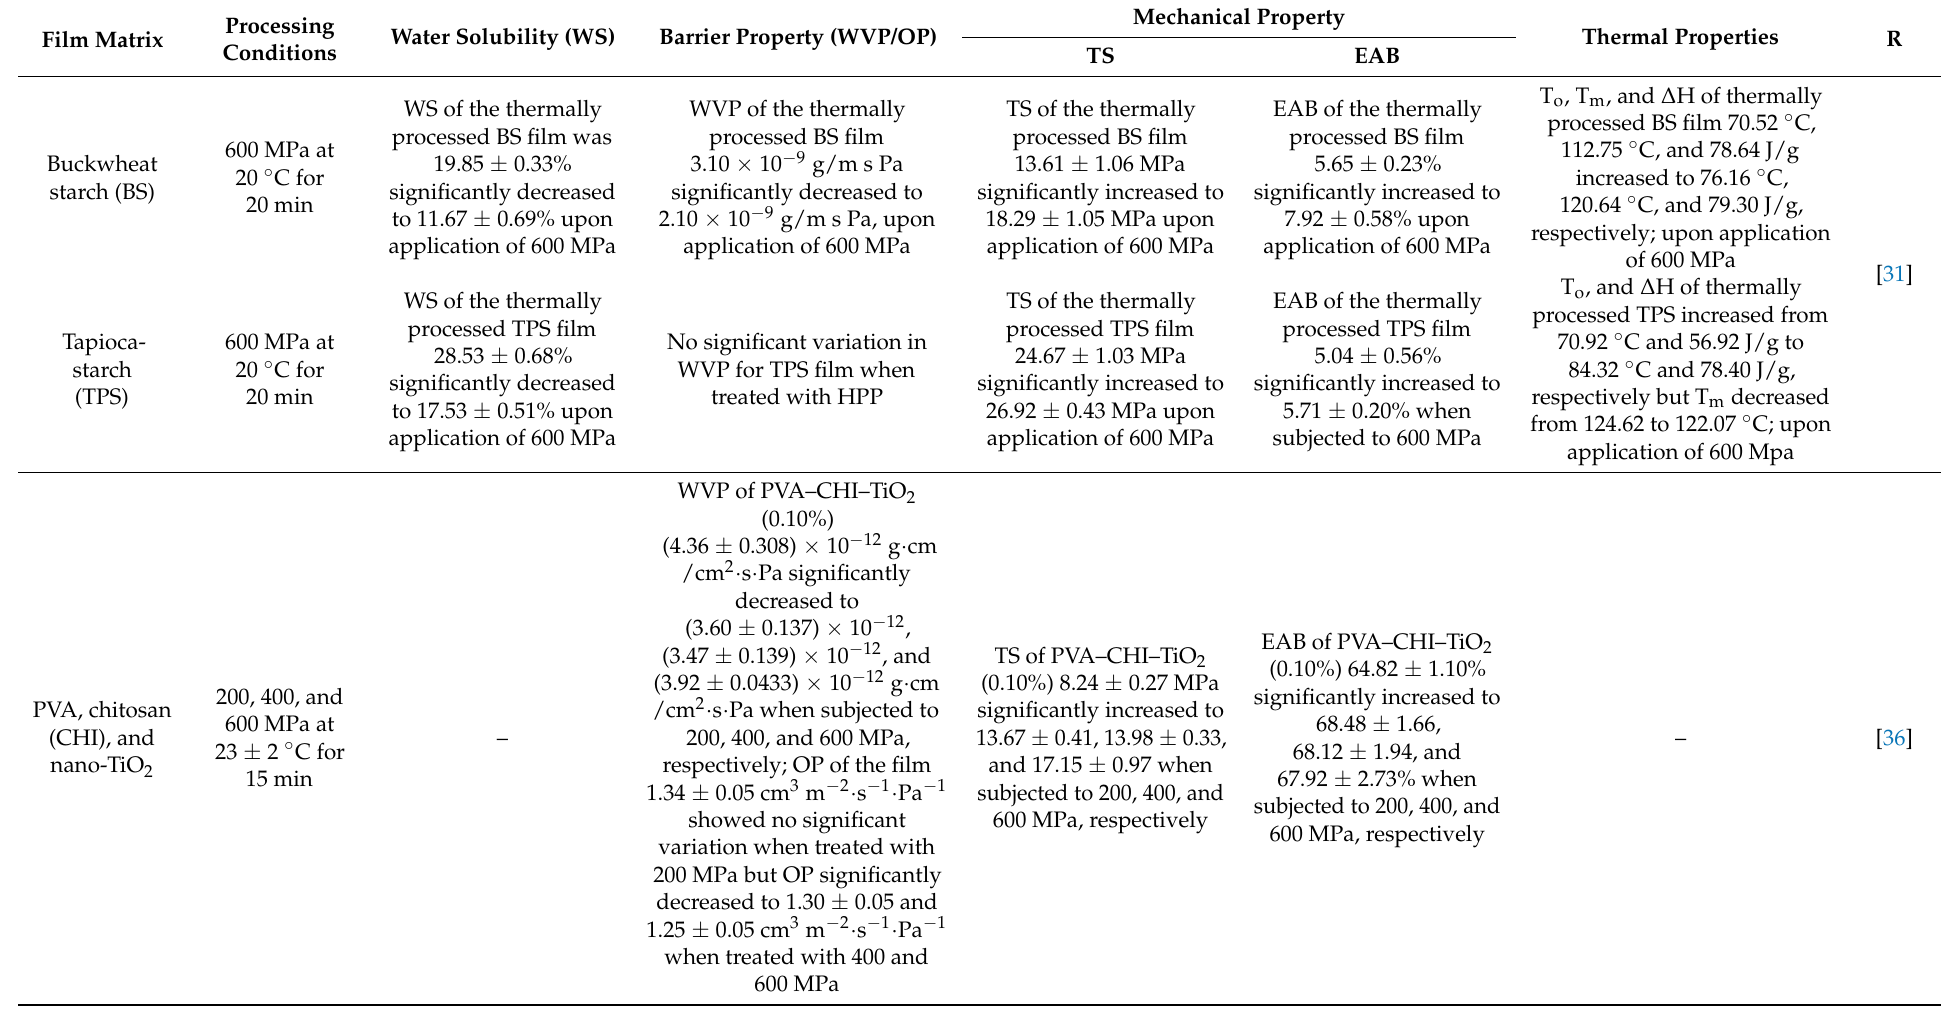
Table 1. Effect of HPP on the film forming solution